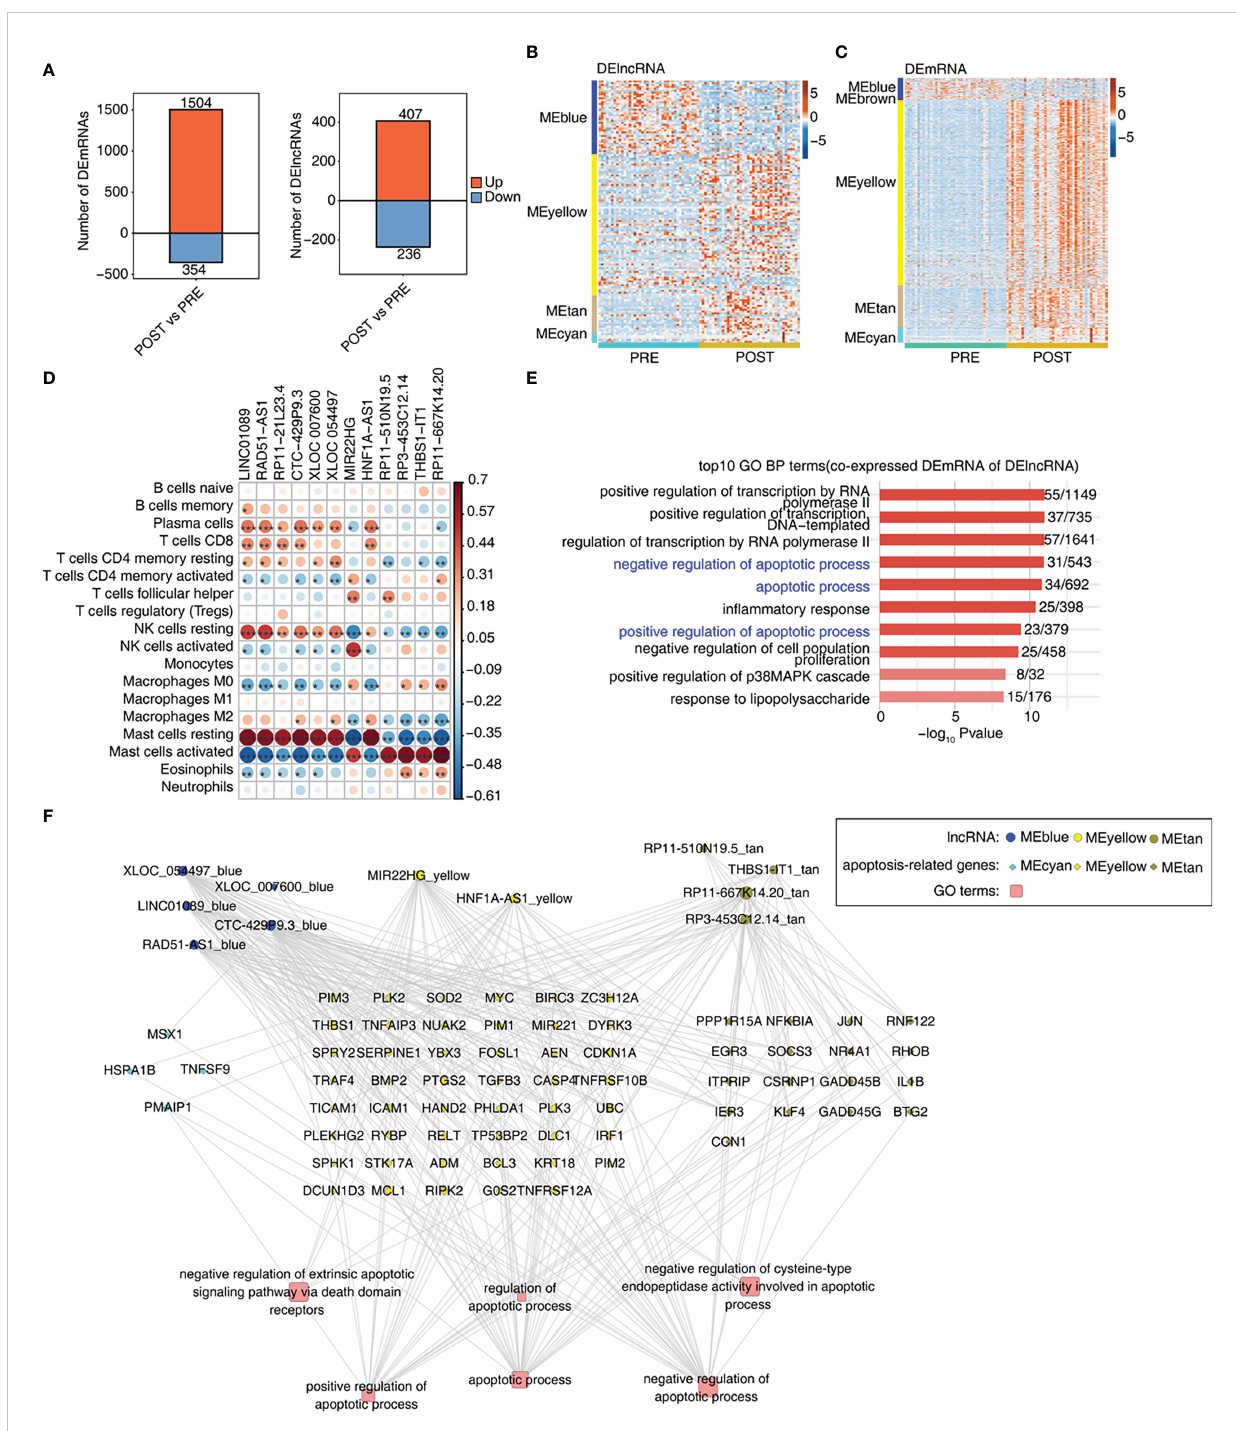
FIGURE 3 Construction of co-expression network between immune-related lncRNAs and DEGs involved in apoptosis. (A) Bar plot shows the number of up- and down-regulated lncRNAs (DElncRNAs) and annotated genes (DEG). DESeq2 is used for differential expression analysis with the criteria set to a p - value ≤ 0.01 and FC ≥ 2 or ≤ 0.5. (B) Heat map shows the expression levels of DElncRNAs in WGCNA module trait with a p -value ≤ 0.01. (C) Heat map shows the expression levels of DEmRNAs in WGCNA module trait with a p -value ≤ 0.01. (D) Co-expression analysis of DE lncRNAs with at least one immune cell with a p -value and Pearson ’ s correlation value ≥ 0.6 or ≤ -0.6. (E) Co-expression analysis of the DEmRNAs from modules in Figure 3C and of DElncRNAs in Figure 3D. Cutoffs of p-value ≤ 0.01 and Pearson coef fi cient ≥ 0.6 or ≤ -0.6 are applied to identify the co-expression pairs. Bar plot exhibits the top GO BP results of co-expressed DEmRNA genes. (F) Network diagram displays the apoptotic pathways of DEmRNAs regulated by DElncRNAs. *p-value < 0.05; **p-value < 0.01; ***p-value <